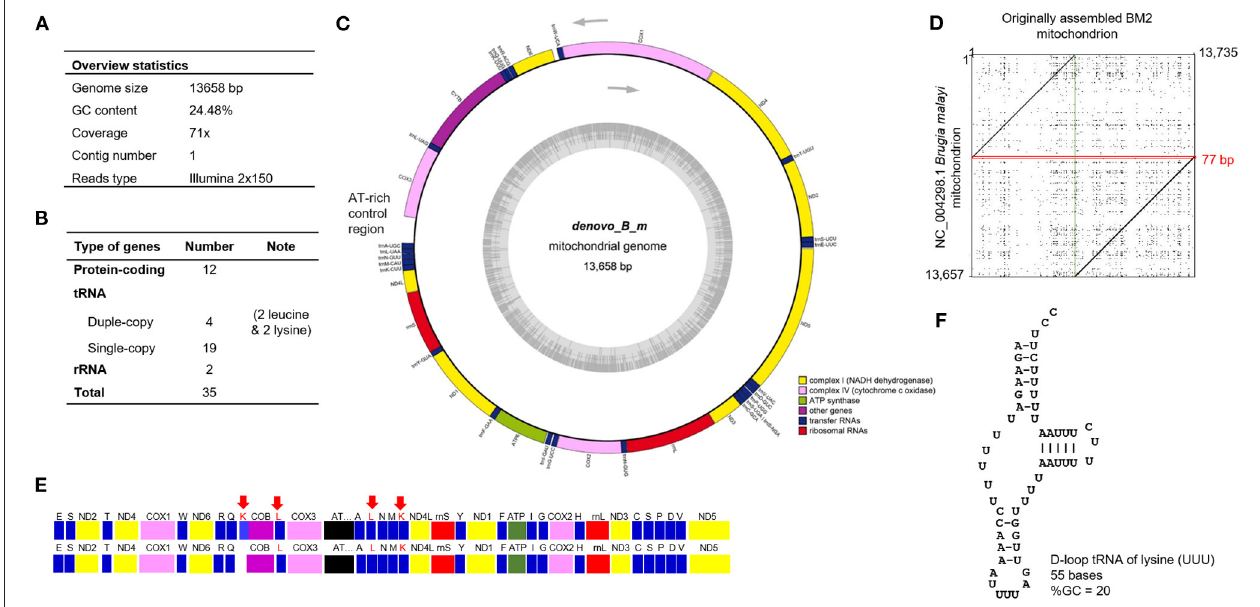
FIGURE 1 | Whole mitochondrial genome of B. malayi isolated from clinical blood samples. (A) Overview of mitochondrial genome of B. malayi . (B) Summary of gene types annotated from mitochondrial genome of B. malayi . (C) A circular layout of mt genome visualized using GeSeq. (D) Dot plot with the sequences of originally assembled BM2 mitochondrion and the mitochondrion of FR3 strain (accession no. AF538716). Overlapped 77-bp sequences on the originally assembled BM2 mitochondrion were marked in the red square, while the junction site without any overlap of two sequences was marked with the vertical green line. (E) Illustration of genes arranged in mt genome of de novo assembled BM2 (upper) and AF538716 (lower). Each type of mt gene is illustrated as a colored box: tRNA (blue), cytochrome (violet), NADH dehydrogenase (yellow), cytochrome c oxidase (pink), ribosomal subunit RNA (red), and ATP synthase (green). Arrows indicate double copy of annotated leucine- and lysine-tRNA genes. (F) Secondary structure of predicted trnK-UUU using ARWEN.